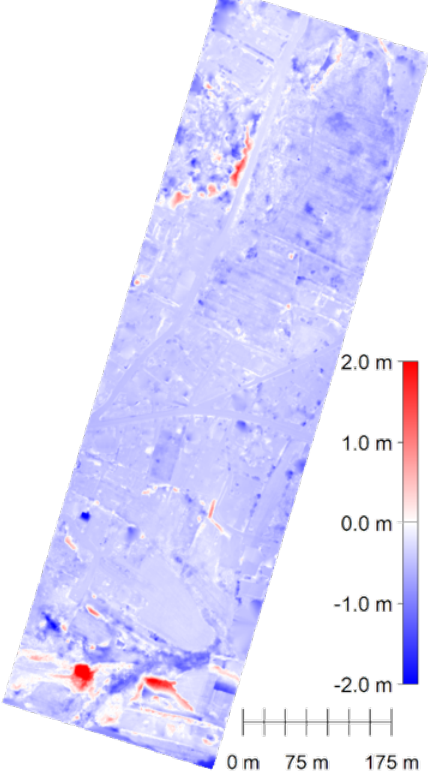
Figure 9 . DoD obtained from models created from UAS photogrammetric data collected in March 2018 and ALS data collected in